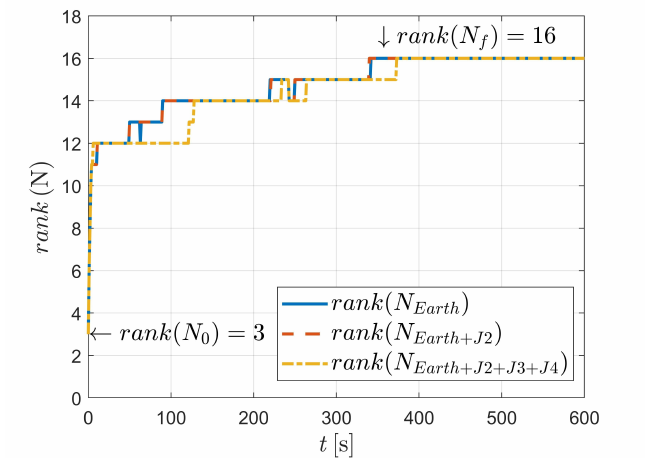
Figure 14. Observability comparisons of case IV.